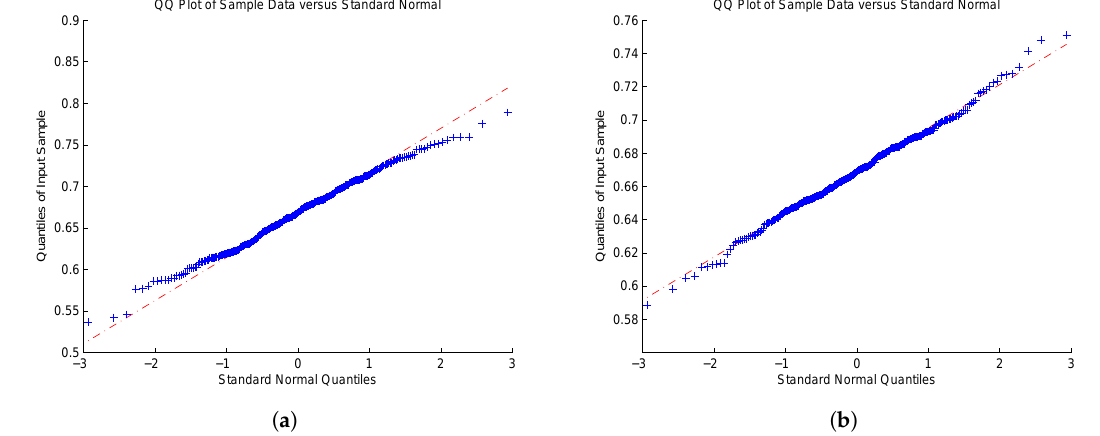
Figure 1. QQ-plot of (cid:98) φ K ( 1 ) for (CP); ( a ) T n = 120, and ( b ) T n = 360.